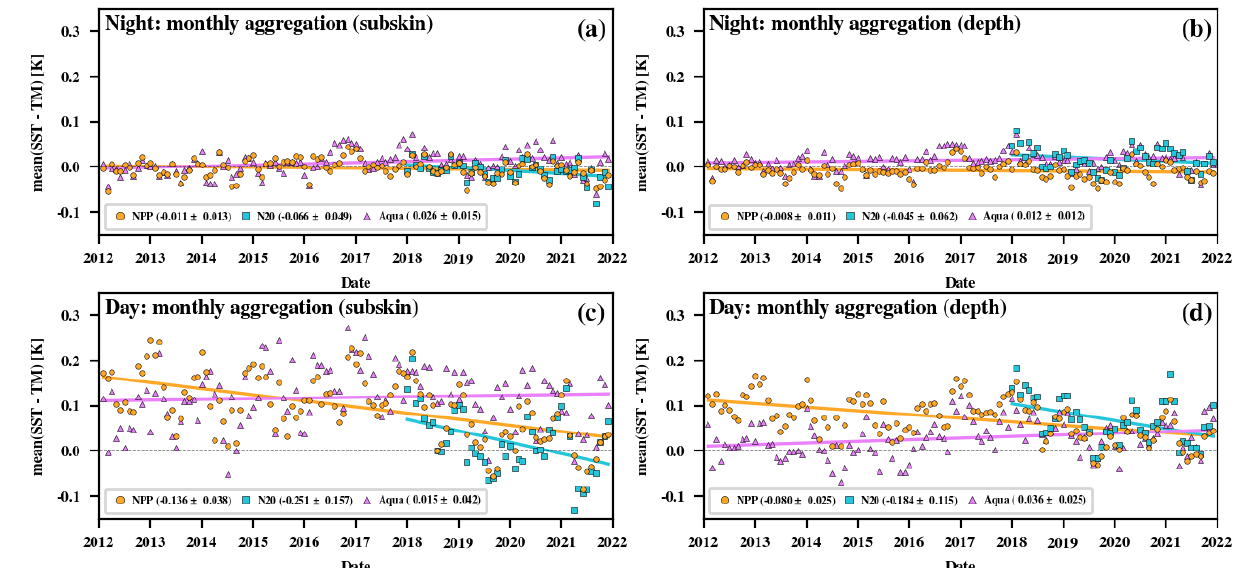
Figure 13. Time series of monthly aggregated nighttime ACSPO − TM SST mean biases: ( a , b ) night- time; ( c , d ) daytime; ( a , c ) ‘subskin’ SST (computed using global regression, GR); ( b , d ) ‘depth’ SST (computed using piecewise regression, PWR). For each time series, the slope (obtained using a linear least square fit) in units of K/decade is overlaid, along with the associated uncertainty obtained using a 95% confidence interval. Lines show the corresponding linear